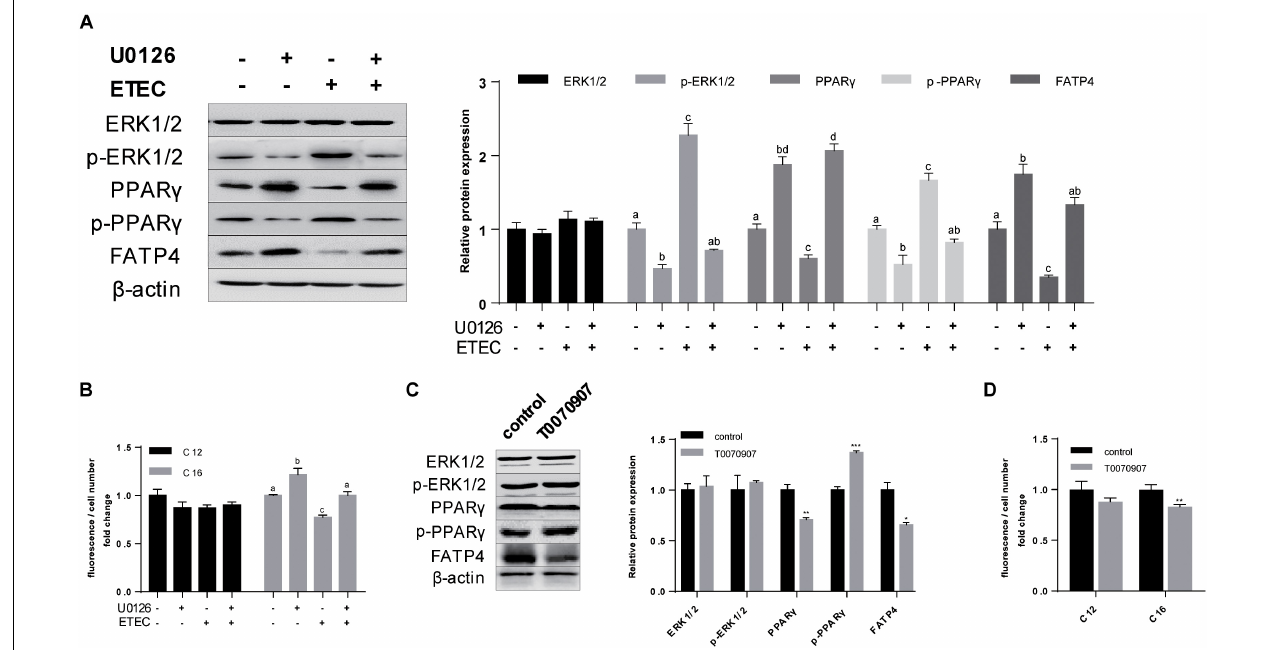
FIGURE 6 | Phosphorylation of ERK1/2 and PPAR γ downregulated the expression of FATP4 by which deteriorated LCFA uptake. (A) Western-blot analysis of ERK1/2, p-ERK1/2, PPAR γ , p-PPAR γ , and FATP4 treated with U0126 ( + / − ) and ETEC ( + / − ). (B) Uptake of Bodipy-labeled C12:0 and C16:0 normalized by cell counting. (C) Western-blot analysis of ERK1/2, p-ERK1/2, PPAR γ , p-PPAR γ , and FATP4 treated with T0070907 ( + / − ). (D) Uptake of Bodipy-labeled C12:0 and C16:0 normalized by cell counting. Data are presented as mean ± standard error. In (A,B) values without a same superscript lowercase differ, P < 0.05; in (C,D) ∗ P < 0.05, ∗∗ P < 0.01, and ∗∗∗ P <